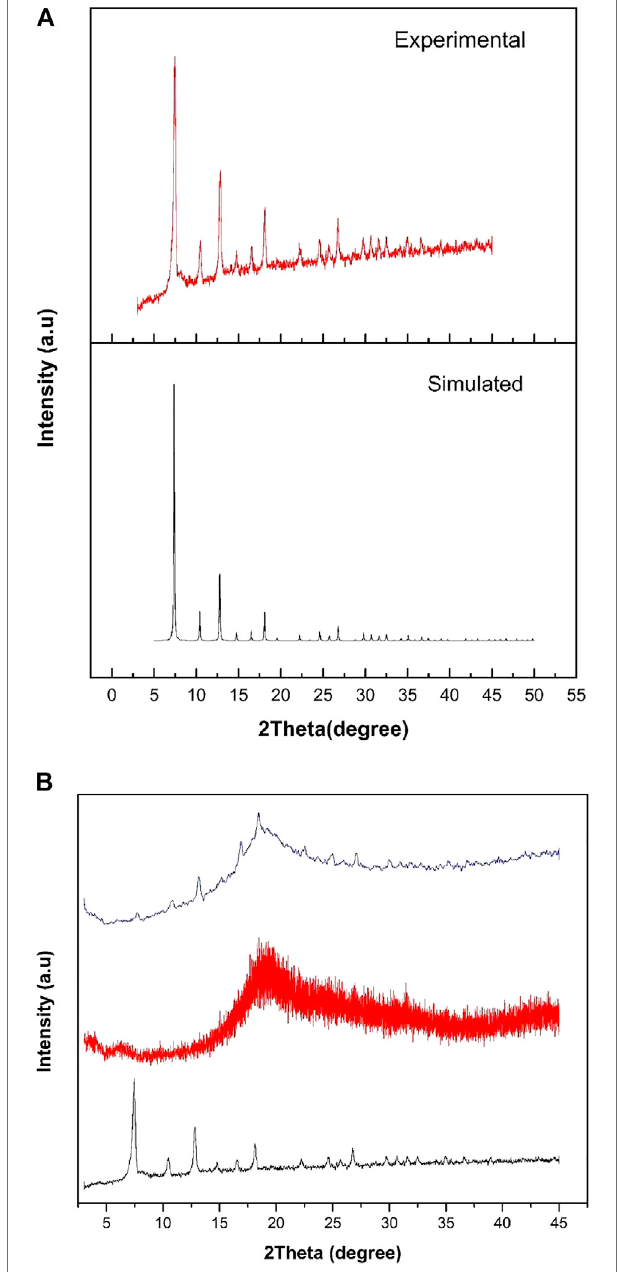
FIGURE1|(A) PXRDpatternofsimulated(Black)andexperimental(red) ZIF-67 and (B) PXRD of ZIF-67(black), 3 wt% ZIF-67 MMM (blue) and pure polysulfone